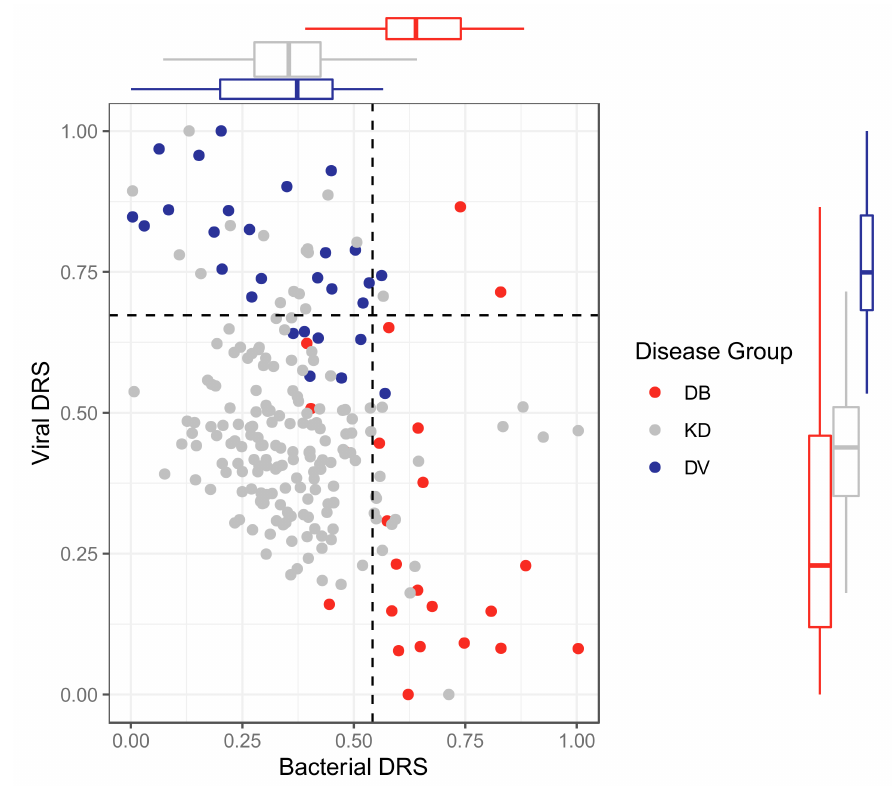
Figure 4. Bacterial DRS (DB-DRS) plotted against viral DRS (DV-DRS) for KD (discovery and validation), DB (from the validation cohort) and DV (from the validation cohort) patients from the transcriptomic datasets. Boxplots are shown for each disease group. KD, DB and DV represent Kawasaki Disease, definite bacterial, and definite viral,